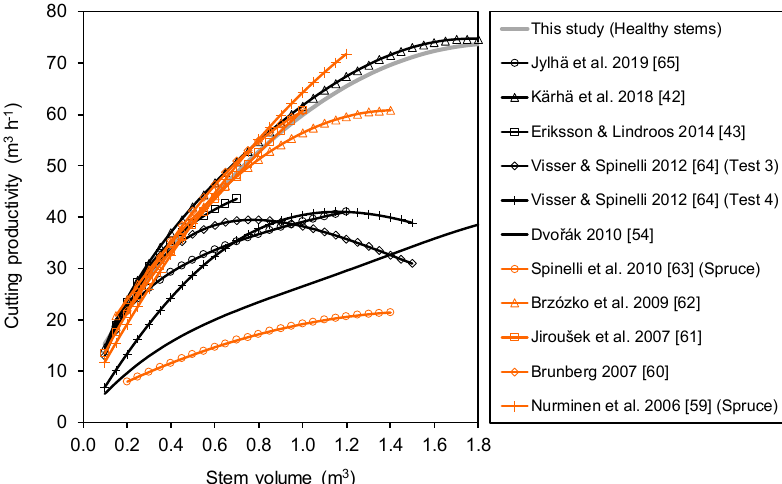
Figure 8. The cutting productivity curves of healthy softwood stems as a function of the stem volume presented by some selected studies from the 21st century in the final fellings [42,43,54,59–65]. All stem volumes and productivities are over bark figures. The productivities by Brunberg [60] and Spinelli et al. [63] are the operating hour productivities (m 3 E 15 − 1 ), and the rest of the cutting productivity curves are the effective hour productivities (m 3 E 0 − 1 ).